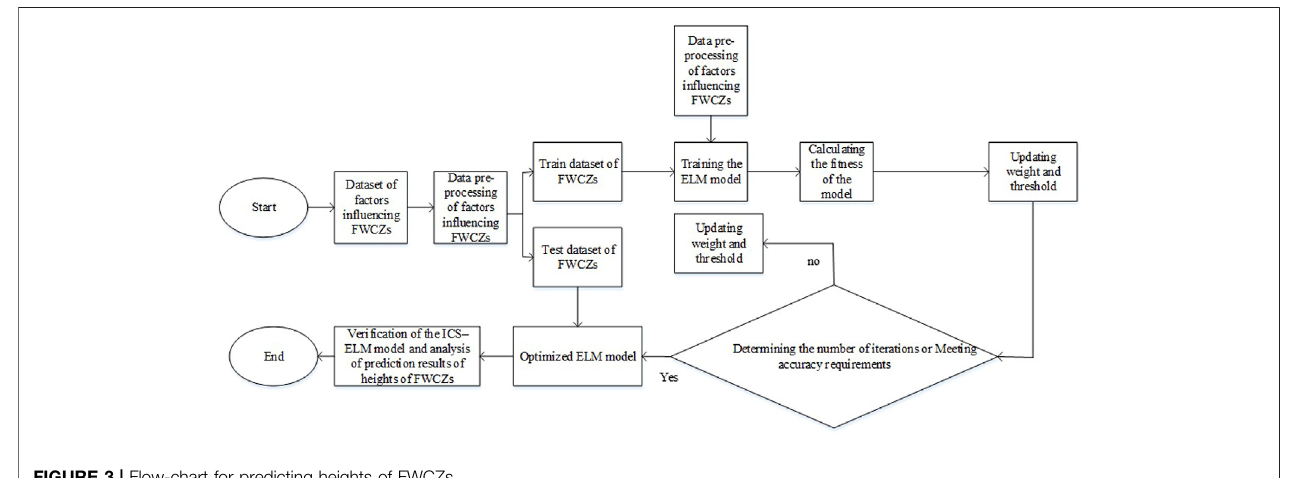
FIGURE 3 | Flow-chart for predicting heights of